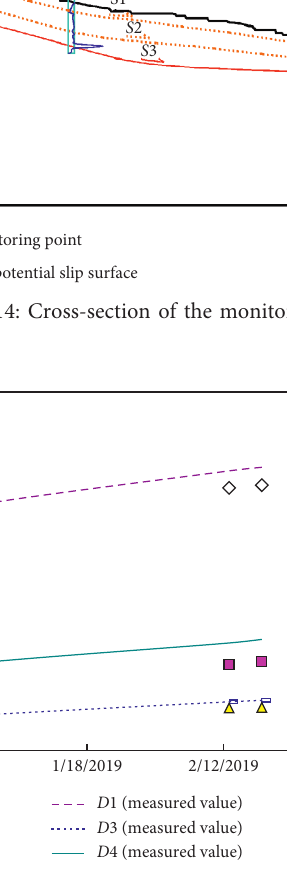
Figure 15: Comparison of the surface displacement calculated by the proposed formula and the measured values.